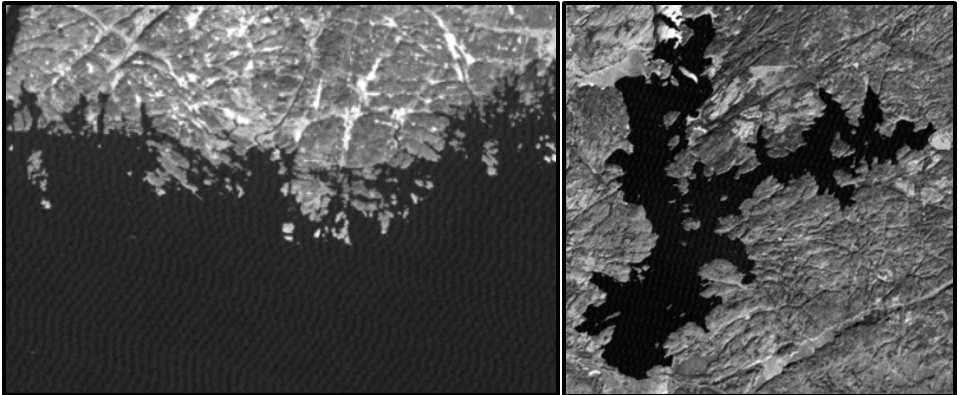
Figure 11. Coherent noise is Landsat 7 ETM+ band 3 ( left ), and Landsat 5 TM band 5 ( right ), level 1 data [156] .